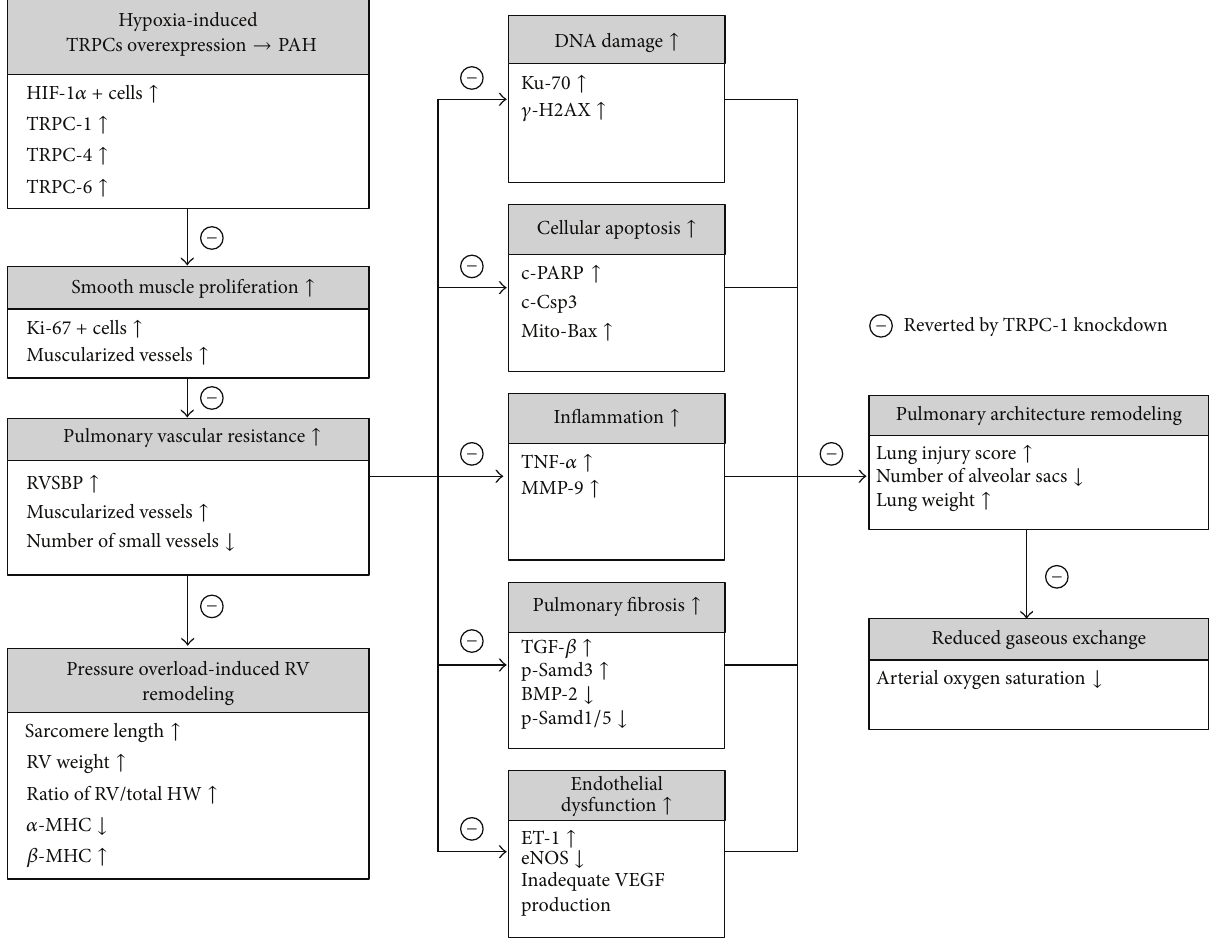
Figure 11: Proposed mechanisms underlying the therapeutic actions of TRPC1 knockdown via Lipofectamine delivered siRNA against hypoxia-induced pulmonary arterial hypertension (PAH) in a murine model of pulmonary arterial hypertension (PAH). 𝛼 -SMA: alpha- smooth muscle actin; BMP-2: bone morphogenetic protein-2; c-Csp3: cleaved caspase-3; c-PARP: cleaved poly(ADP-ribose) polymerase; eNOS: endothelial nitric oxide synthase; ET-1: endothelin-1; HIF-1 𝛼 : hypoxia-inducible factor 1-alpha; HW: heart weight; MHC: myosin heavychain;mito-Bax:mitochondrialBax;MMP-9:matrixmetalloproteinase-9;p-Smad:phosphorylatedSmad;RVSP:rightventriclesystolic pressure; TGF- 𝛽 : transforming growth factor beta; TNF- 𝛼 : tumor necrosis factor alpha; TRPC: transient receptor potential cation channel; VEGF: vascular endothelial growth factor